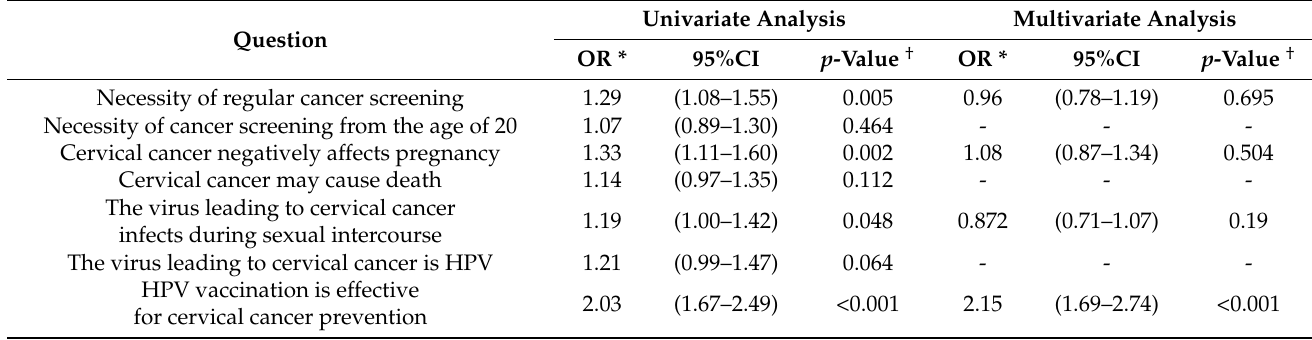
Table 2. Knowledge of cervical cancer screening and HPV